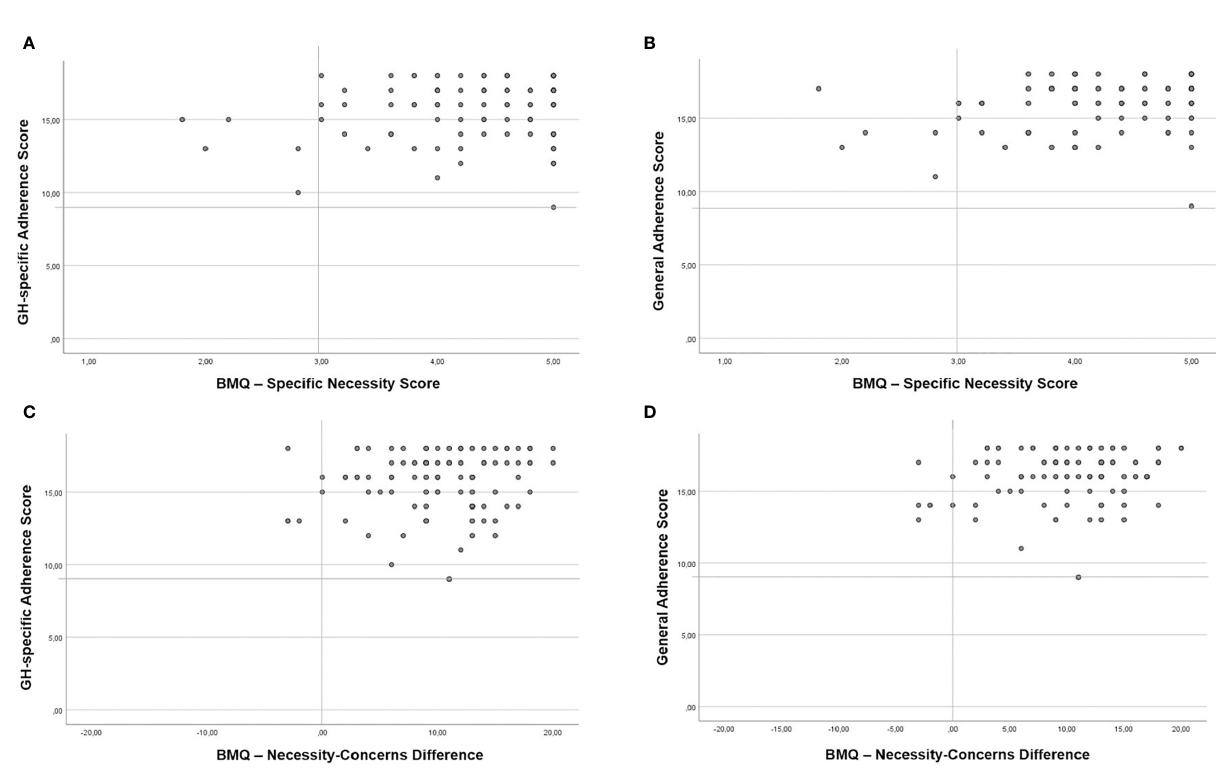
FIGURE 1 | BMQ Speci fi c Necessity Scores in relation to GH-speci fi c Adherence (A) and General Adherence (B) and BMQ Necessity-Concerns Difference in relation to GH-speci fi c Adherence (C) and General Adherence (D) .